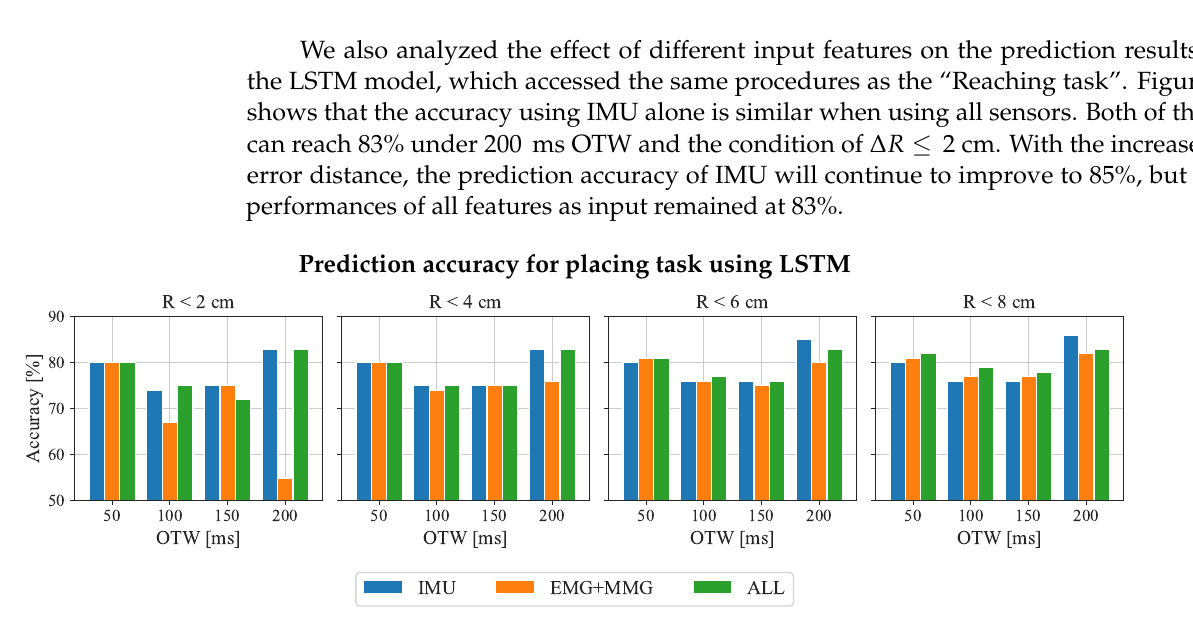
Figure 8. Prediction accuracy of the “placing task” for different combinations of input features for all participants subjects. The LSTM model is the main model to be analyzed in this section. The blue bars represent the results that only use kinematic input features labeled as IMU. The orange bars refer to the physiological features input only, labeled as EMG + MMG. Results with the combinations of input features are shown in green (labeled as